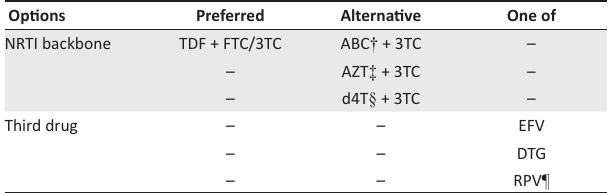
TABLE 4: Preferred first-line regimen